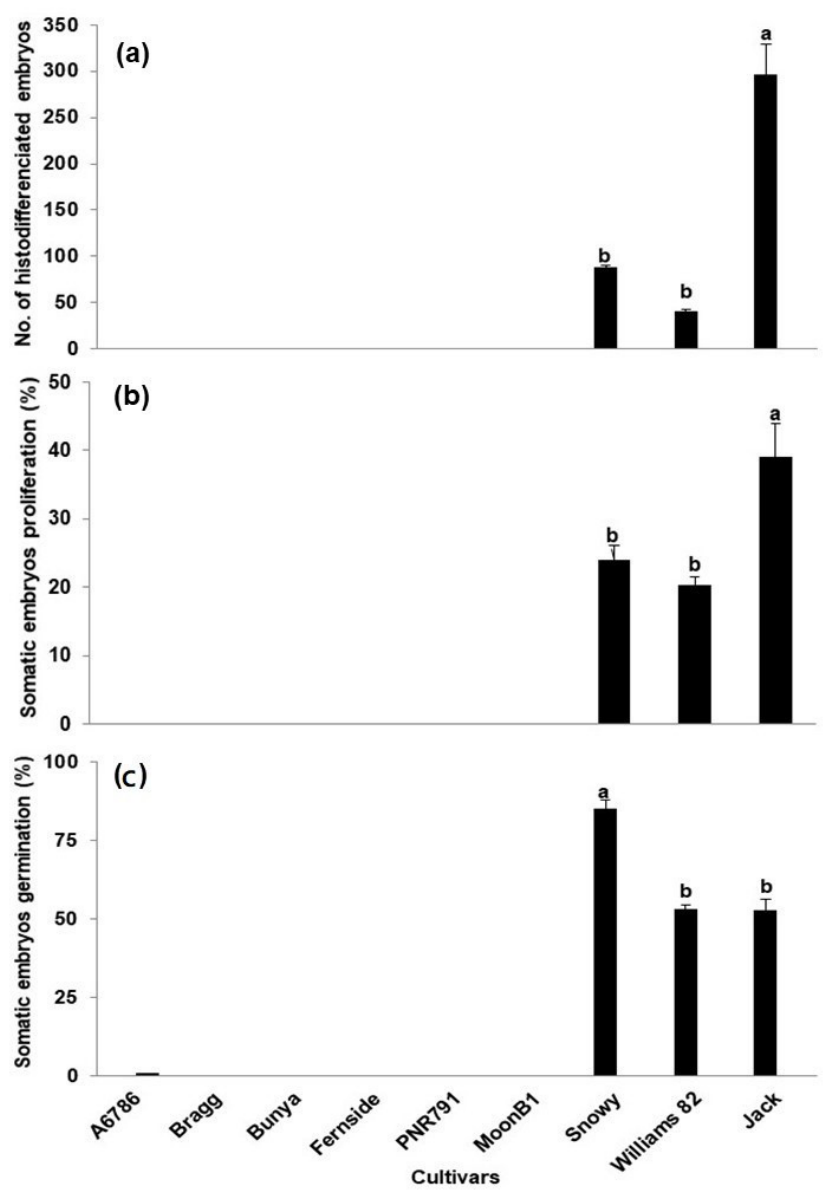
Figure 4. Proliferation, maturation, and germination of somatic embryos in soybean cultivars, ( a ) number of proliferated somatic embryos, ( b ) number of matured somatic embryos, and ( c ) germination percentage of matured somatic embryos. Data points represent the mean ± S.E. of three replicates. Column values with different letters are statistically significant at p < 0.05.